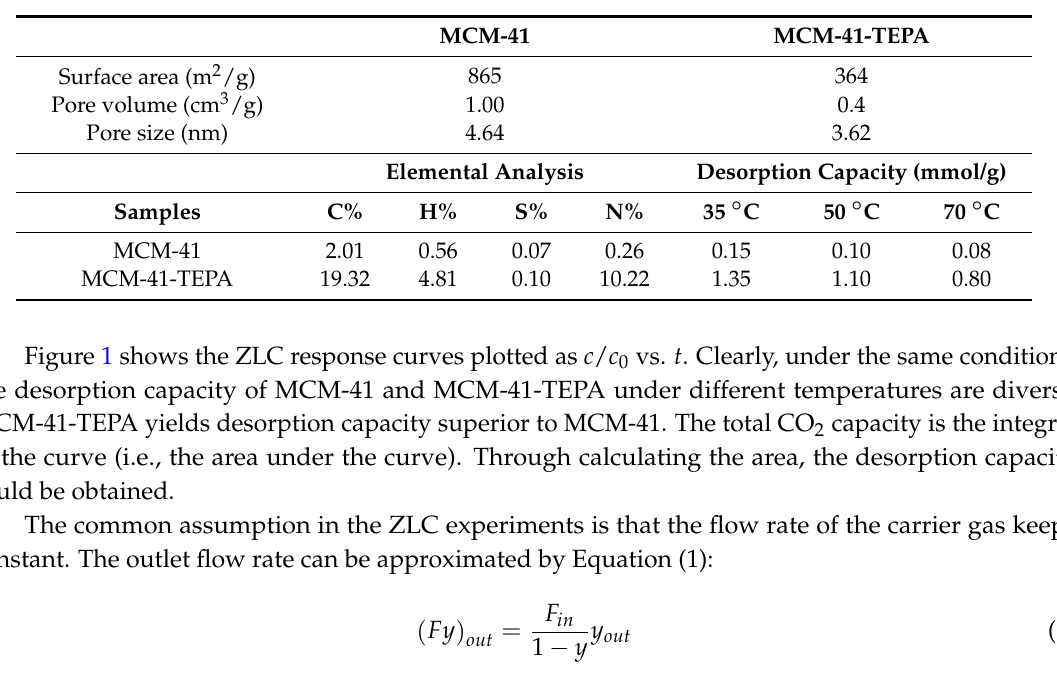
Table 1. The characteristics and the operation condition of MCM-41 and